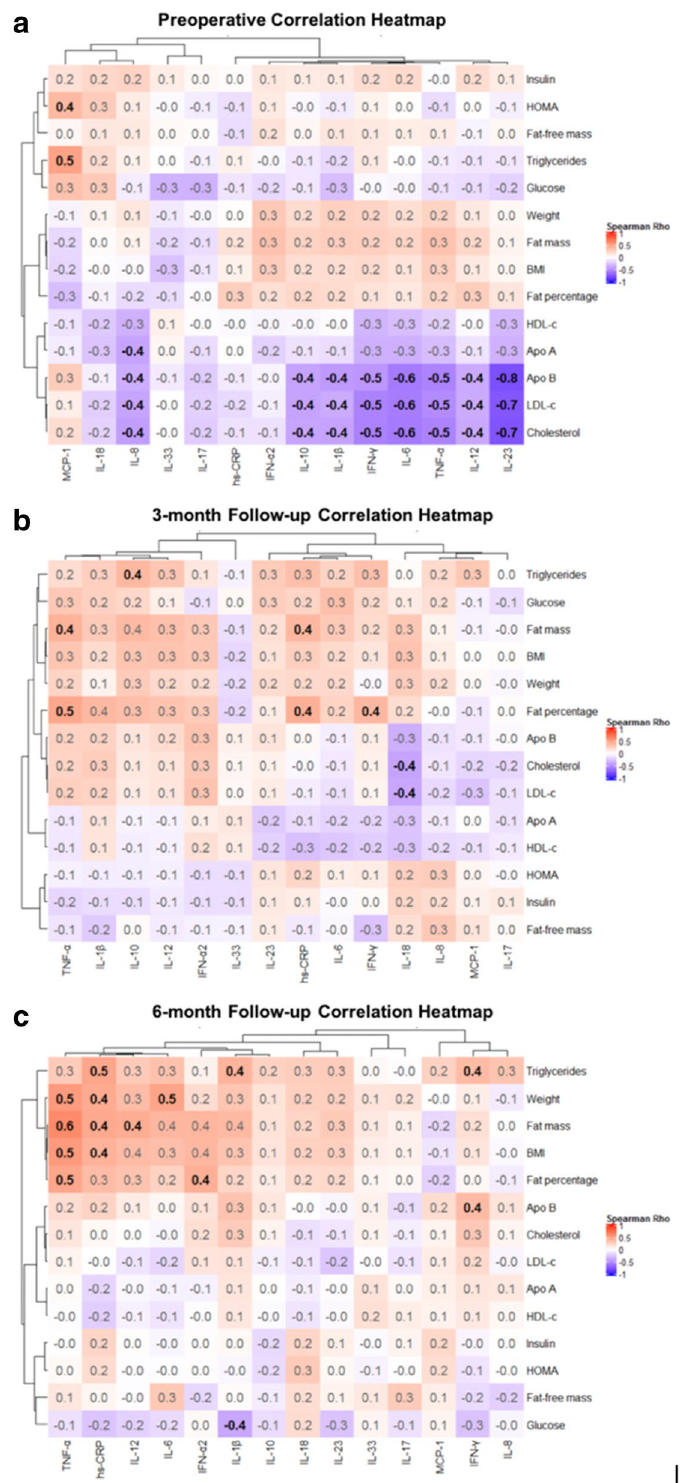
Figure 3. Correlation heatmaps: Inflammatory markers, anthropometric indicators, body composition parameters, and biochemical variables. n = 32. Spearman’s rho rank correlation coefficient is rounded to one decimal and shown in black and bold font for statistically significant findings ( p -value < 0.05). Red squares represent positive values; Blue squares represent negative values. ( a ) Preoperative; ( b ) Postoperative 3-month follow-up; ( c ) Postoperative 6-month follow-up. Apo: Apolipoprotein, BMI: Body Mass Index, HDL-c: High Density Lipoprotein Cholesterol, HOMA-IR: Homeostatic Model Assessment for Insulin Resistance, LDL-c: Low Density Lipoprotein Cholesterol, hs-CRP: high sensitivity C-reactive protein, IFN: Interferon, IL: Interleukin, MCP: Monocyte Chemoattractant Protein, TNF: Tumor Necrosis Factor. This figure was made with the help of Complex Heatmaps Package in R